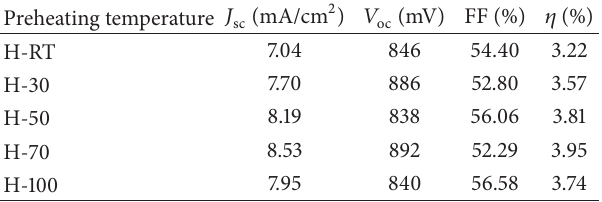
Table 1: Experiment average parameters and sample calibration of different substrate